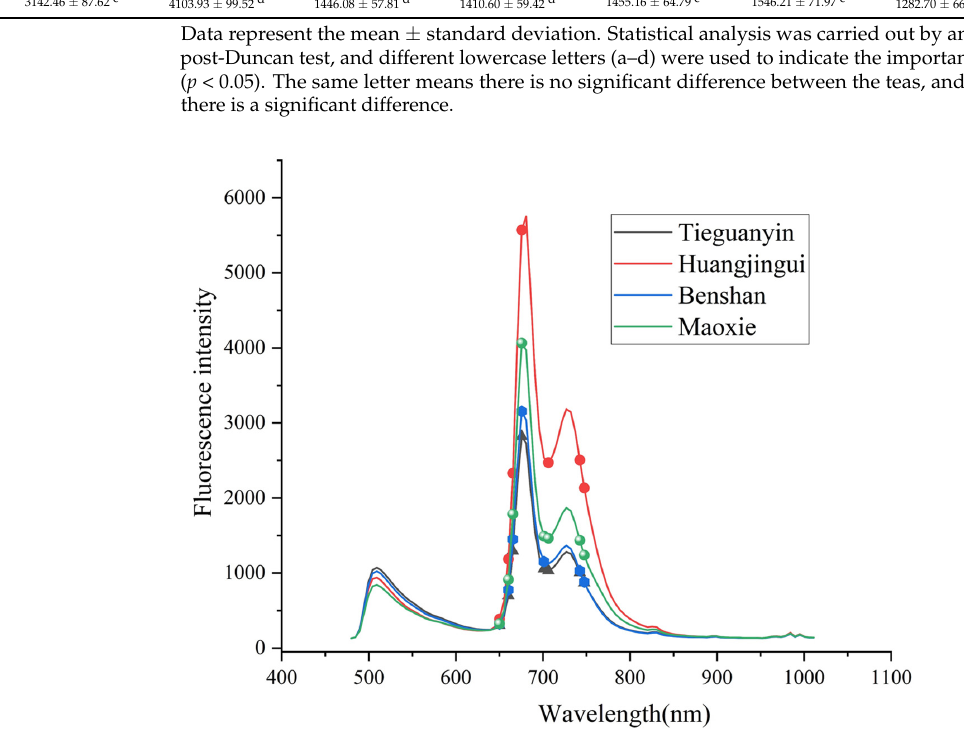
Figure 4. Distribution of key wavelengths in the average